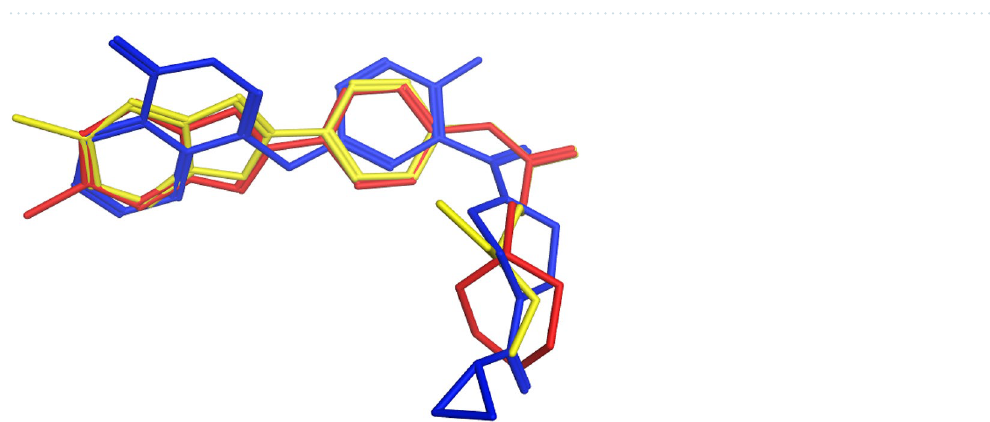
Figure 14. The ligand conformations of ( a ) olaparib, ( b ) 27 and ( c ) 12 inside PARP-2 binding pocket surface map.